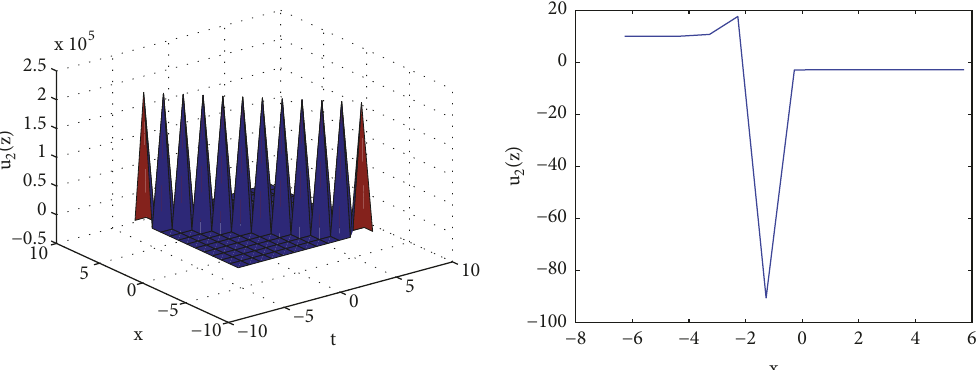
Figure 2: The 3D and 2D surfaces of 𝑢 2 (𝑧) by considering the values 𝛾 = 4 , 𝜇 = 3 , 𝑘 = 1 , 𝐿 = 1 , 𝜆 = −43 , 𝑦 = 0 , 𝑎 = 1 , and 𝑡 = 0 for the 2D